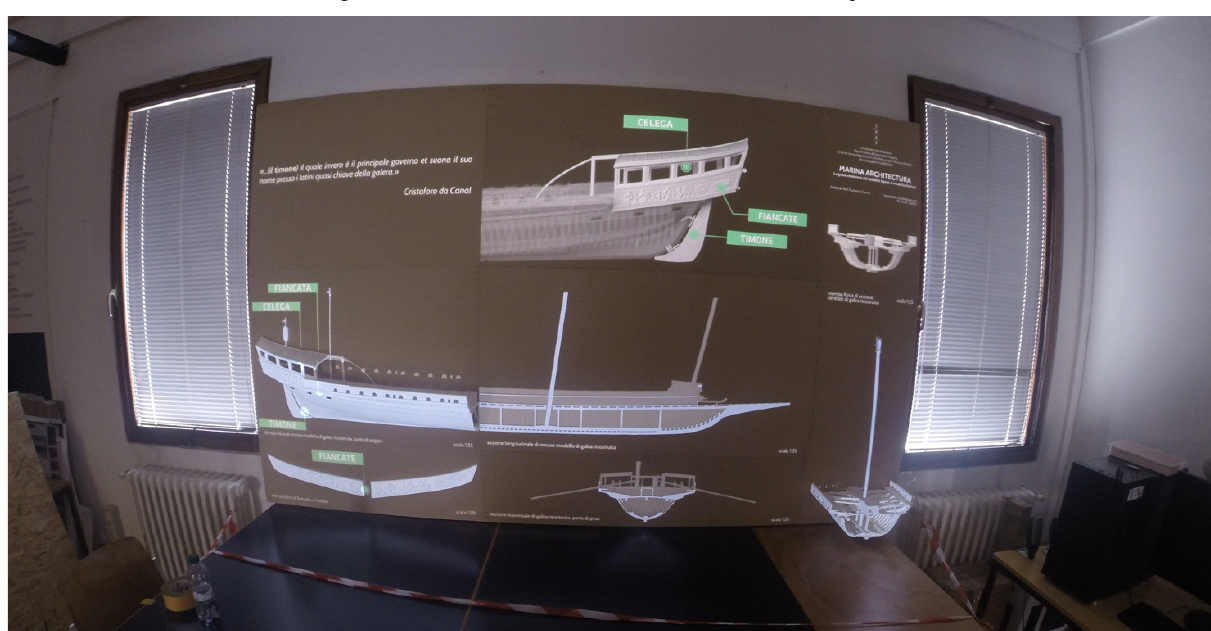
Figure 11. 3 D Printed models mounted on the installation panel